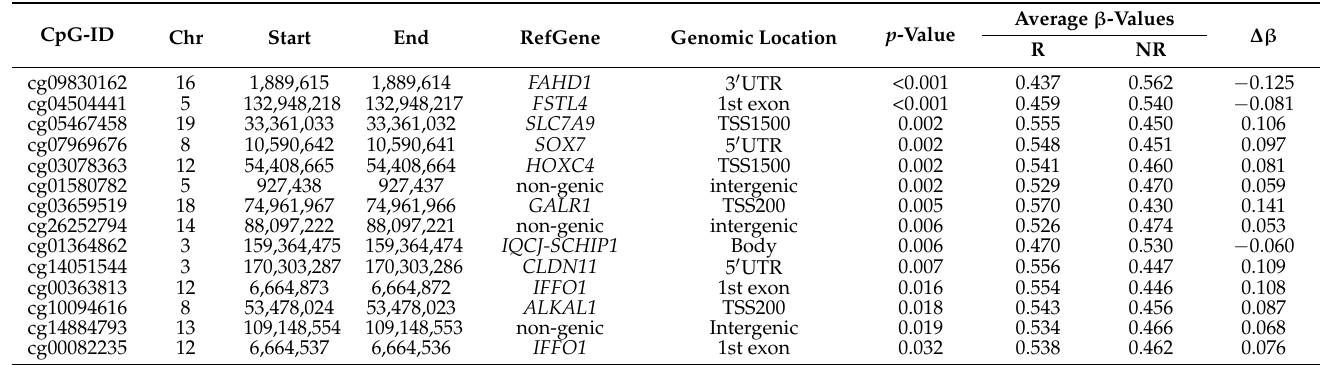
Figure 3. Genomic characterization of DMRs (5% Δβ ). ( A ) Distribution of the percentage of differential DNAme of the 392 identified DMRs between recurrent and non-recurrent groups; ( B ) genomic annotations of the identified DMRs in the human genome. Plot generated using ChIPseeker package; ( C ) DMR plots showing chromosome localization and the differential DNAme of GALR1 and ( D ) IFFO1 regions. The average methylation values in recurrent (red) or non-recurrent (blue) cases are demonstrated.